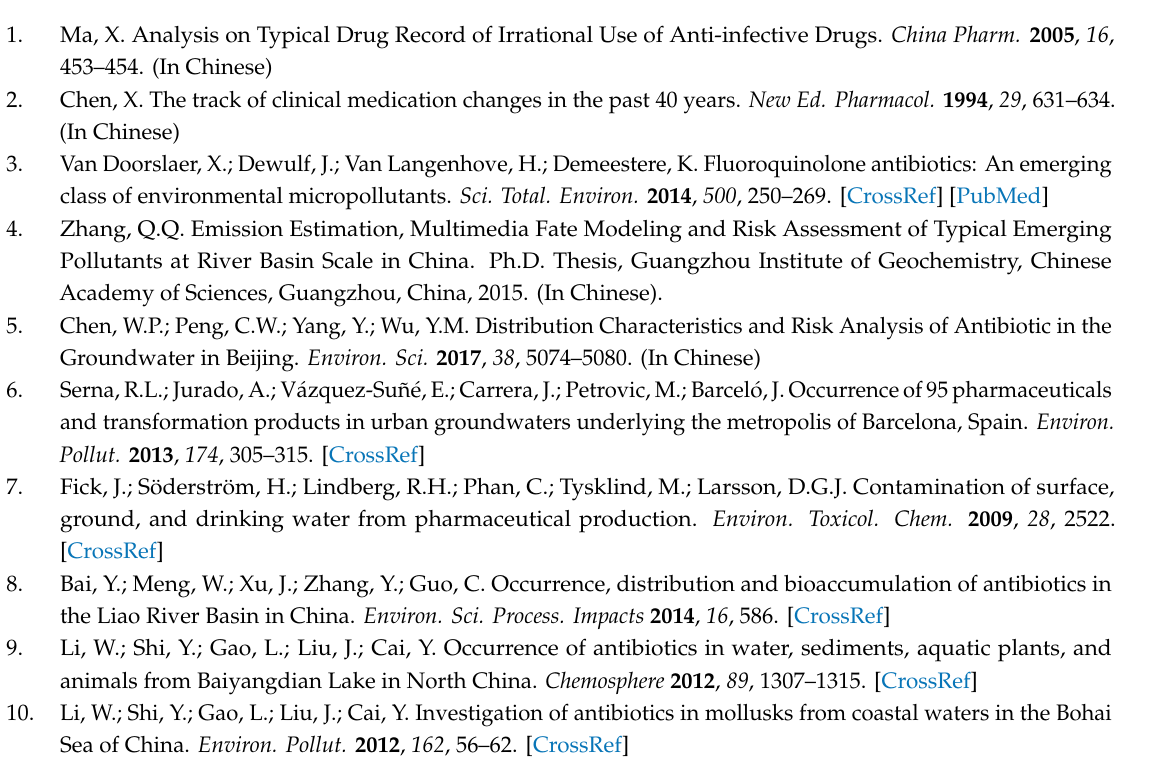
Figure S1: Relationship between each QA structure and the associated activities (i.e., IRI, UVI and CI) with (a) marbofloxacin and (b) levofloxacin used as the target molecules, Table S1: Molecular structures of designed QA